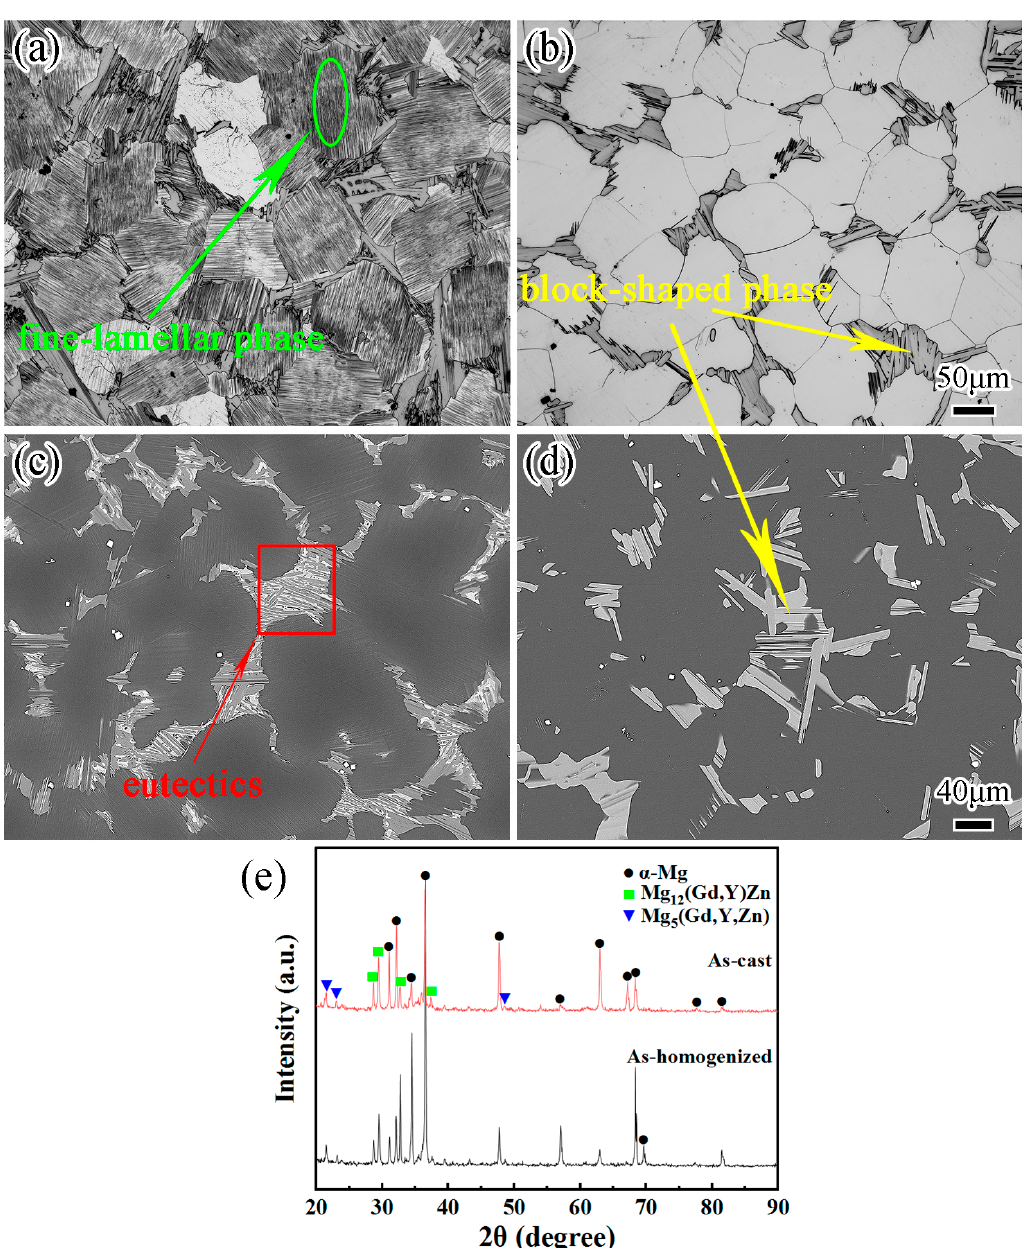
Figure 3. Optical microscopy (OM) micrographs of the GWZK124 alloys: ( a ) as-cast; ( b ) as-homogenized, and their corresponding back-scattered electron (BSE) micrographs ( c , d ). XRD patterns of GWZK124 alloys in as-cast and as-homogenized states ( e ).